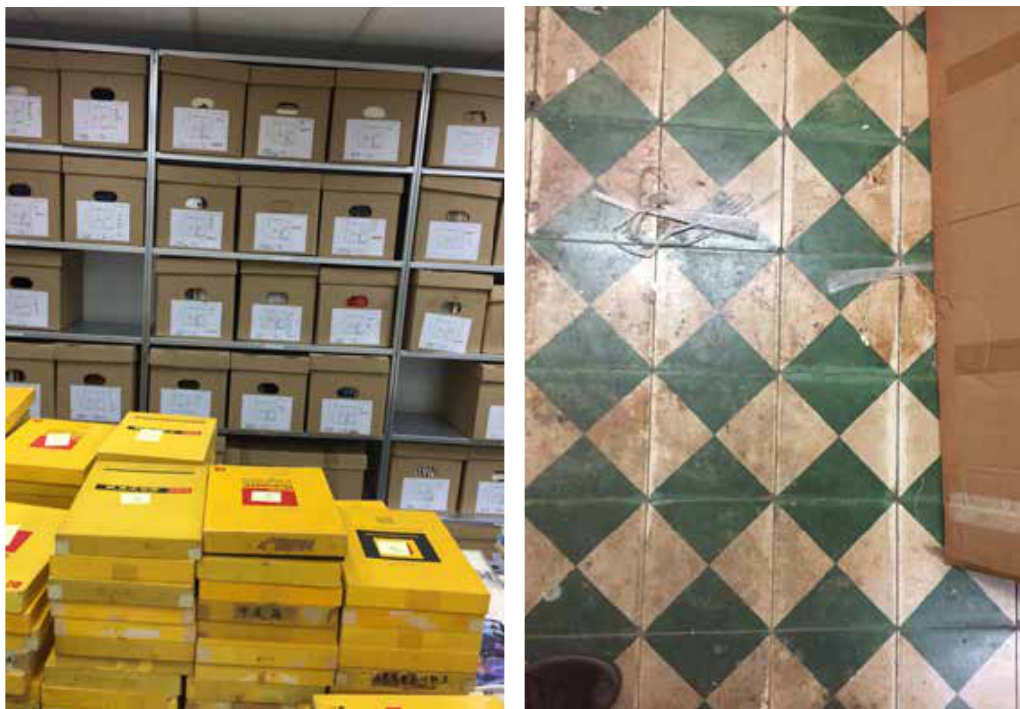
Figure 3: Ha’s family home in To Kwa Wan. Source: Chow Yiu-Fai.